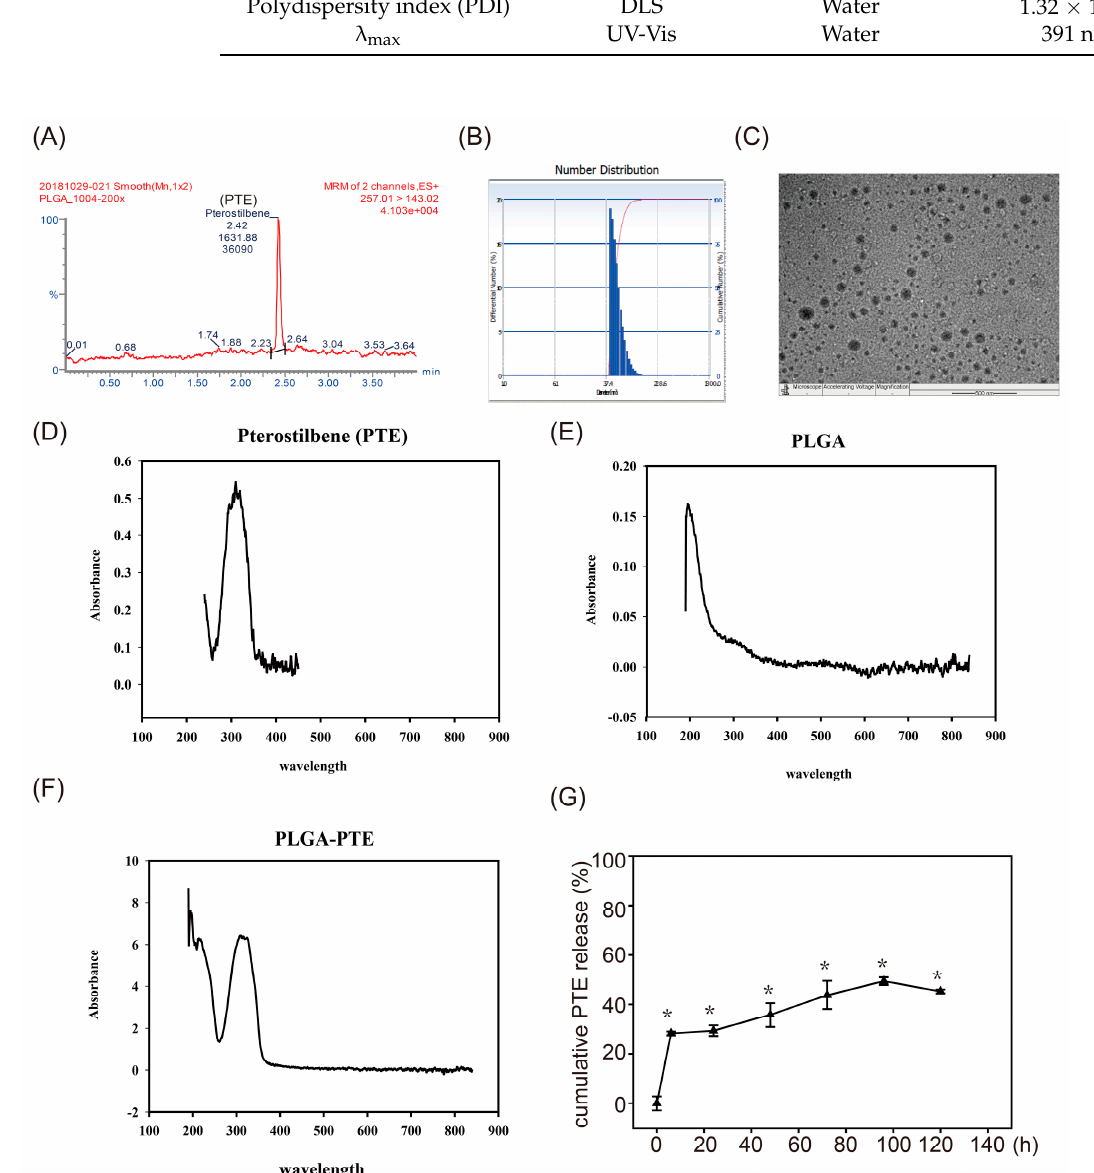
Figure 2. Physicochemical properties of poly(lactic-co-glycolic acid)-pterostilbene (PLGA-PTE). ( A ) HPLC chromatogram of PLGA-PTE ( B ) Transmission electron microscopy analysis revealed that all of the synthesized PLGA-PTE was spherical in shape (scale bar = 500 nm). ( C ) The mean hydrodynamic size of PLGA-PTE determined by dynamic light scattering (DLS) is 56.9 ± 13.6 nm and the polydispersity index (PI) is 0.155. The following figures are the UV-Vis absorption spectra of ( D ) PTE, ( E ) PLGA, and ( F ) PLGA-PTE. Comparison of the visible light absorption spectrum of UV light confirmed that PLGA-PTE was successfully synthesized. ( G ) The cumulative drug release of PTE from PLGA NPs formulation at different time points was detected by UV-Vis spectrophotometer at 310 nm. Triangle symbol indicated the PTE concentration released in water. The data are presented as the mean ± standard deviation of three independent experiments.* p < 0.05 compared with 0 h groups.